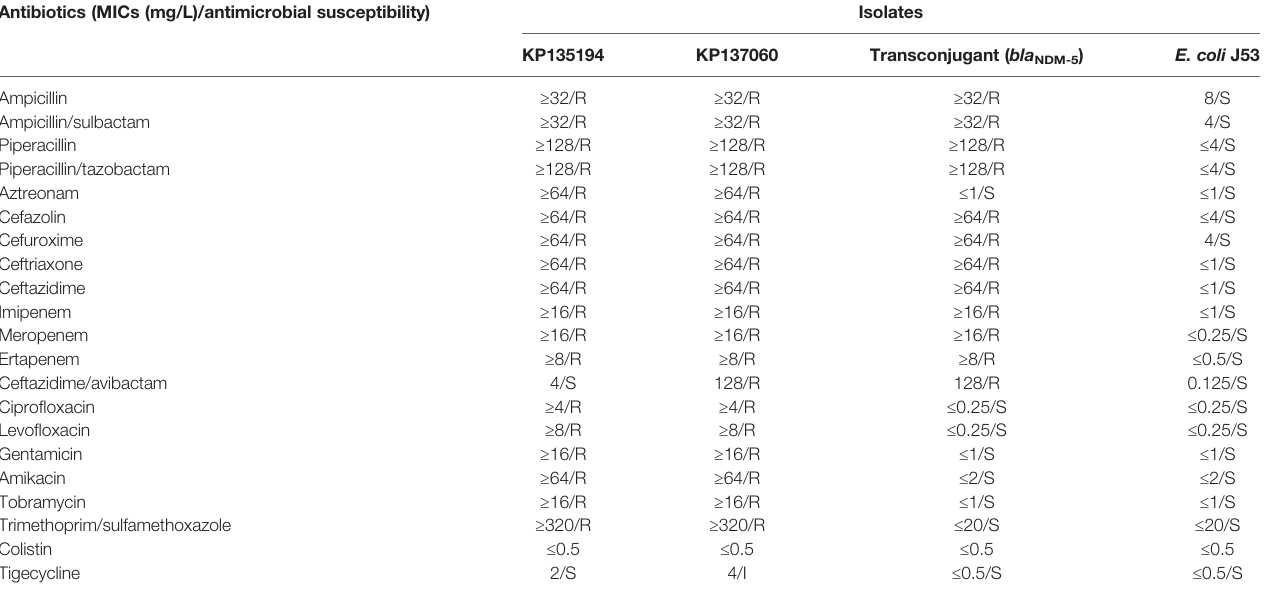
TABLE 1 | Minimal inhibitory concentrations (MICs) of two CR-KP isolates, the bla NDM-5 -positive E. coli transconjugant and E. coli J53 recipient strains. Antibiotics (MICs (mg/L)/antimicrobial